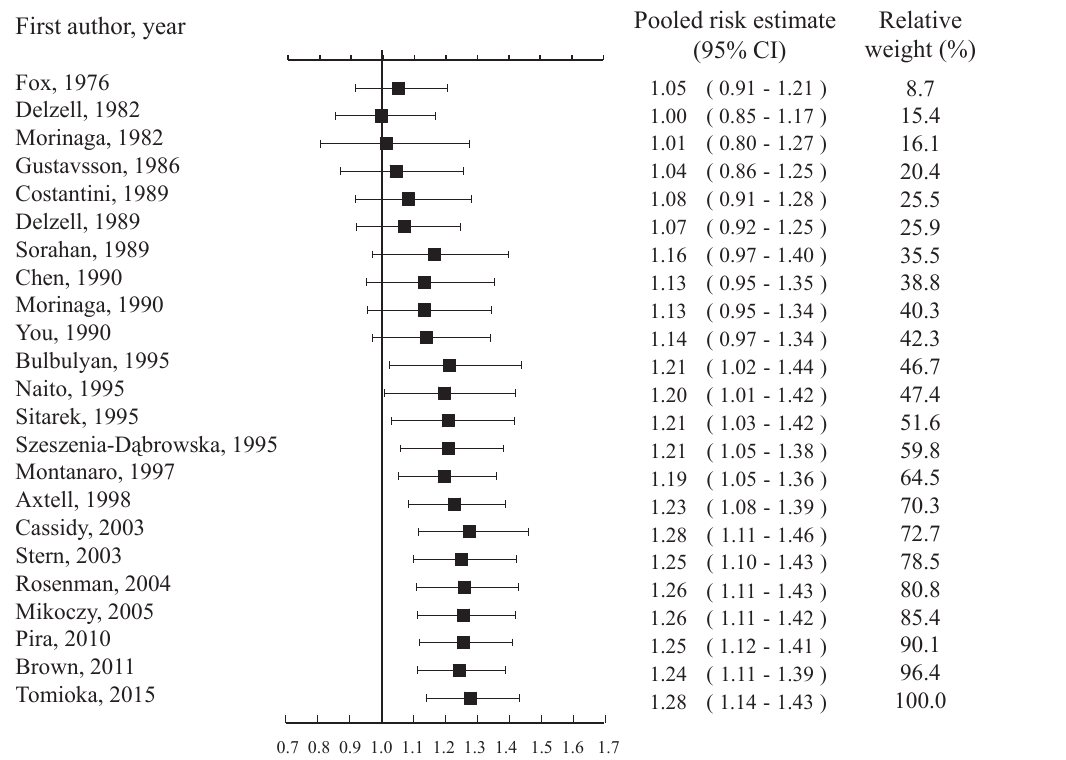
Figure 3. Forest plot of cumulative meta-analysis of lung cancer and occupational exposure to benzidine and/or beta- naphthylamine. Pooled risk estimates (with 95% con fi dence intervals) by year of publication of subsequent reports. Vertical solid lines = no